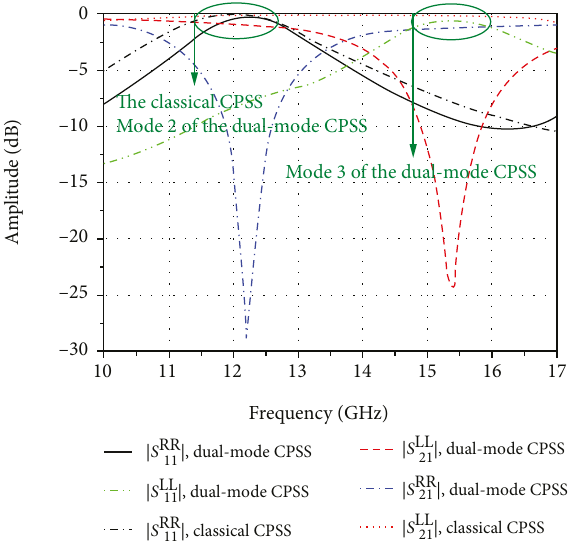
Figure 4: Comparison of the CP discrimination capabilities between the dual-mode CPSS and the classical CPSS.